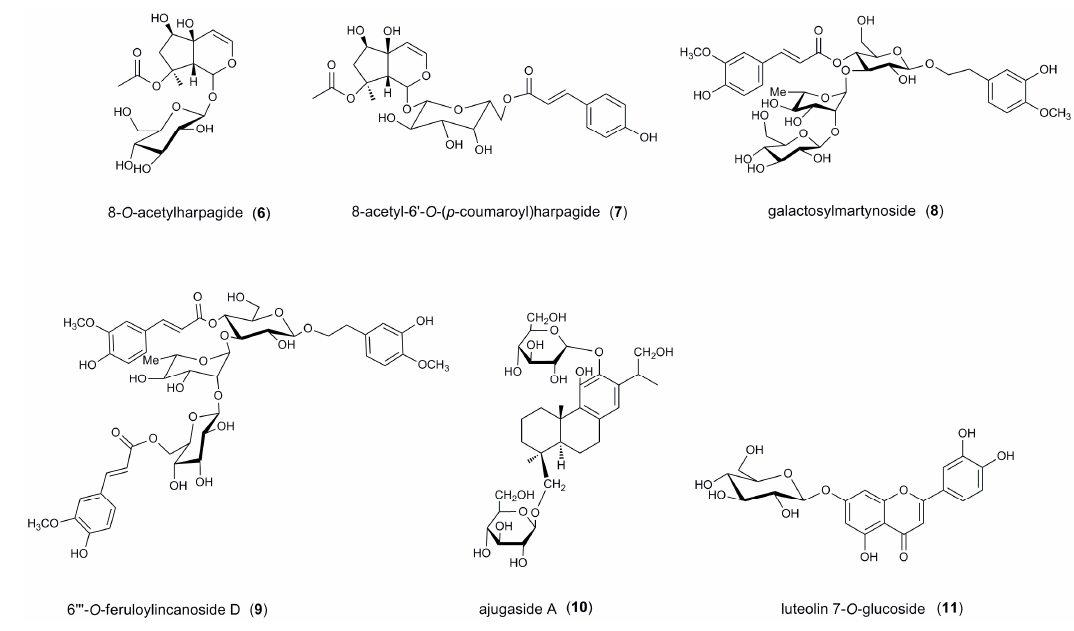
Figure 6. Chemical structures of isolated compounds 6 – 11 . Table 3. The IC 50 (mM) values of α -glucosidase inhibitory activity of the isolated compounds, 1 – 11 , and acarbose as the control. Each value is shown as a mean ± standard derivation of three replicates. Compounds IC 50 Compounds IC 50